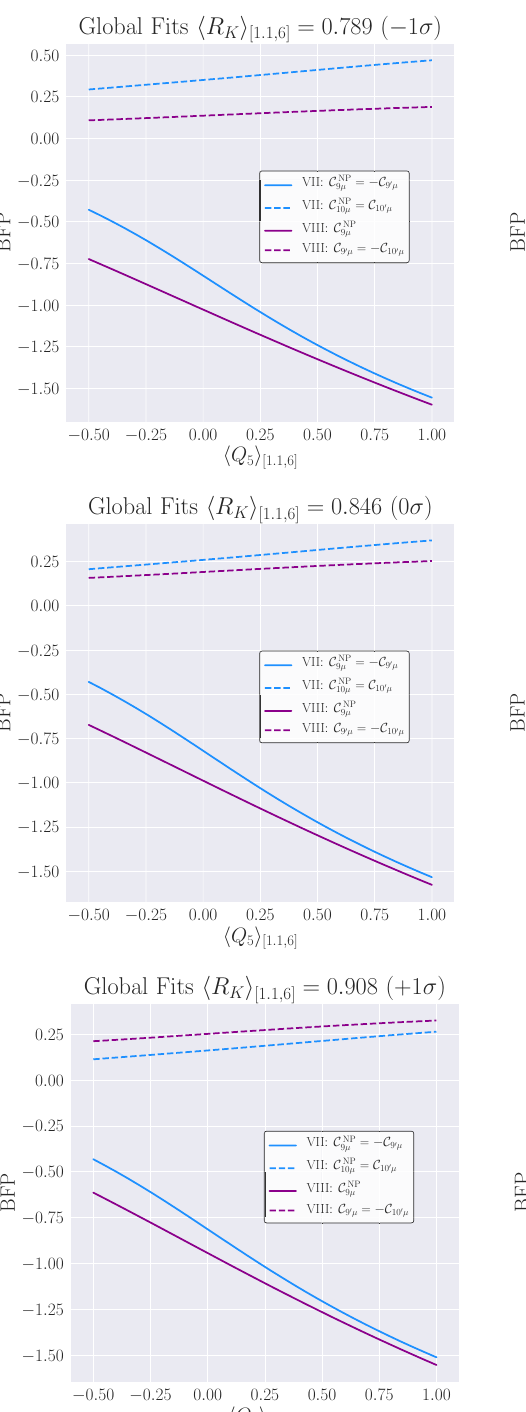
on the b.f.p.s of the NP hypotheses under consideration Q 5 (cid:31) (cid:30) [1 . 1 , 6] R K (cid:30) [1 . 1 , 6] (cid:31)